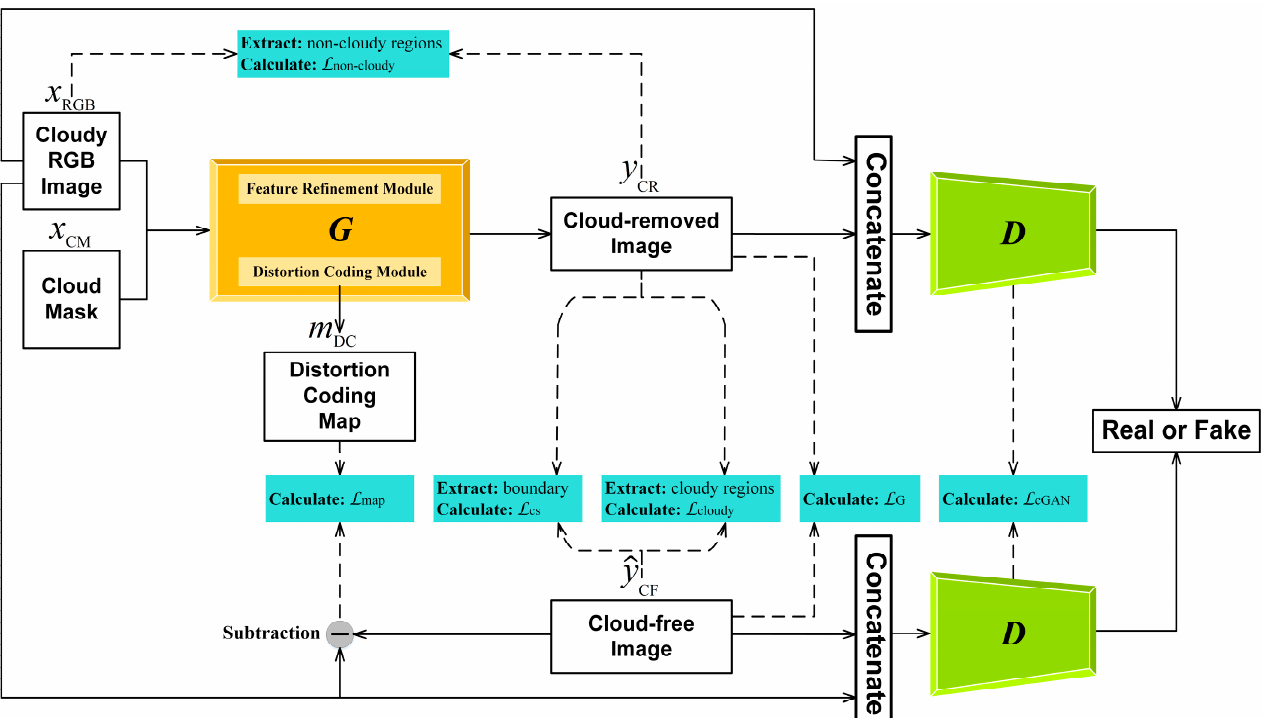
Figure 1. The proposed DC-GAN-CL framework.